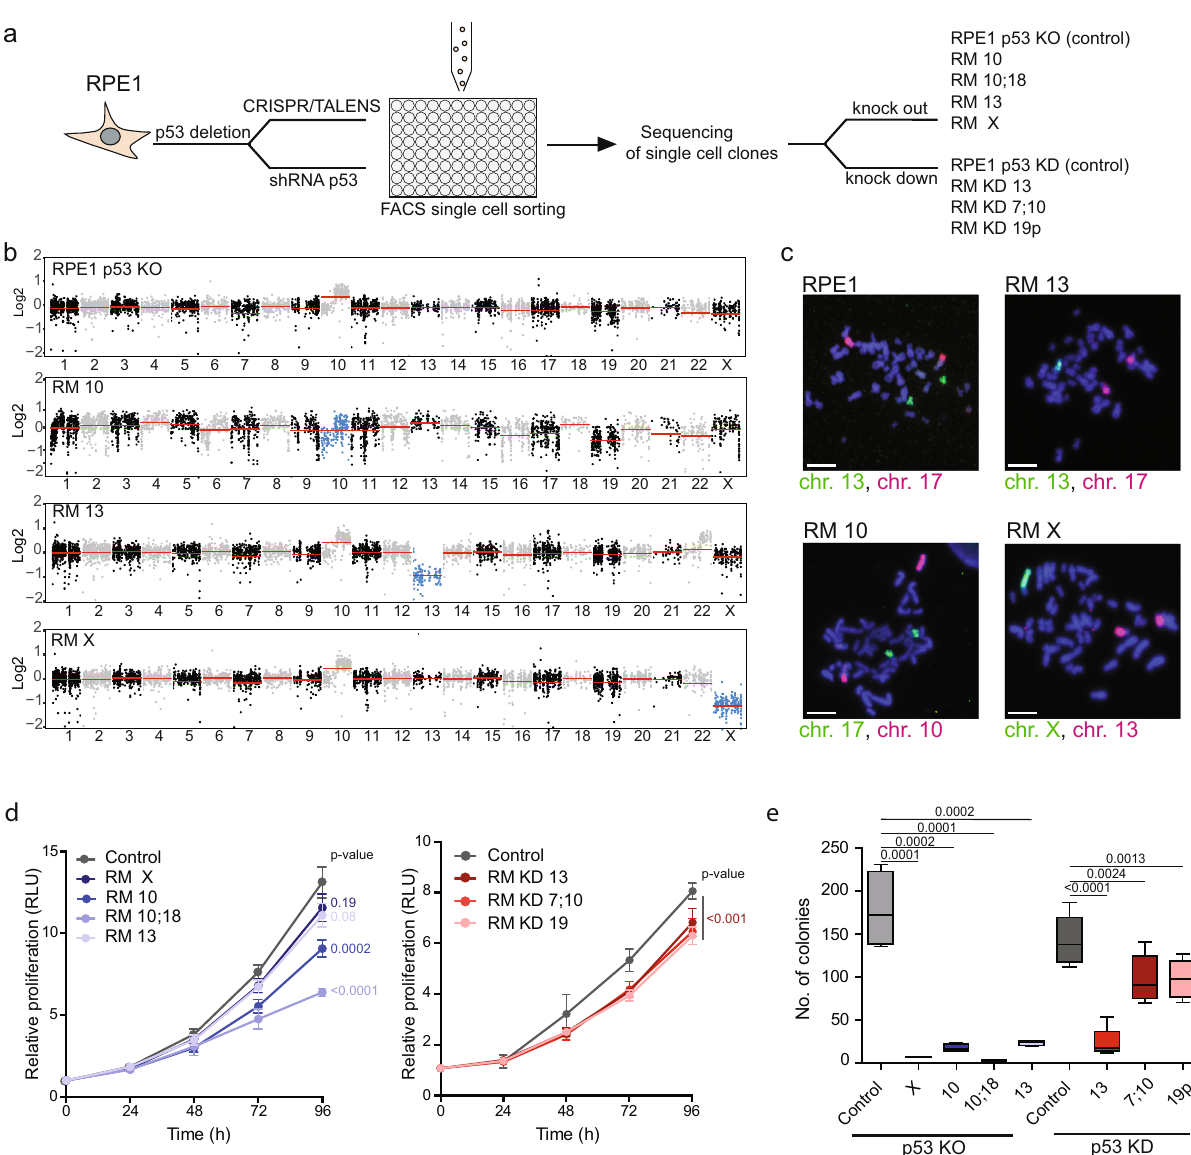
Fig. 1 Chromosome loss in p53 de fi cient cells reduces proliferation and anchorage independent growth on soft agar. a Schematic depiction of the construction of monosomic cells. p53 was mutated or depleted in RPE1-hTERT cell line via CRISPR/Cas9, TALENS, or shRNA expression. Clones arising from single cells were subjected to whole-genome sequencing and monosomic clones were selected to be used in further experiments. b Read depth plots of all chromosomes in control and RM samples. Chromosome losses are marked in blue. Red lines indicate the copy number of each chromosome. Note that the parental RPE1 contains an extra copy of 10q that is preserved in all monosomic derivatives. c Chromosomal paints of monosomic cell lines. The painted chromosomes are indicated with respective colors. Representative images of one experiment are shown. Scale bar — 10 µ m. d Proliferation curves of monosomic cell lines in comparison to respective diploid controls. All the values are normalized to day 0. Each point represents the mean ± SEM. Number of biological replicates: RPE1 P53 KO control = 7, RM X = 7, RM 10 = 7, RM 10;18 = 7, RM 13 = 7; RPE1 P53 KD control = 5, RM KD 13 = 5, RM KD 7;10 = 5, RM KD 19p = 5). RLU-relative luminescence unit. Statistical signi fi cance is calculated using linear regression analysis; p -values are shown in the plots. e Quanti fi cation of number of colonies growing on soft agar. The median is shown as a black bar and Whiskers are chosen to show the 1.5 of the interquartile range. Number of biological replicates: RPE1 P53 KO control = 4, RM X = 4, RM 10 = 4, RM 10;18 = 4, RM 13 = 4; RPE1 P53 KD control = 8, RM KD 13 = 8, RM KD 7;10 = 8, RM KD 19p = 8. Statistical analysis was performed using one-tailed unpaired T -test; p -values are shown on the plot. Source data are provided in a Source Data fi Gene expression changes caused by monosomy are partly autophagy proteins was not uniformly deregulated (Supplemen- buffered at both mRNA and protein levels . To obtain a global tary Fig. 2a – e). Taken together, a loss of single chromosome leads to proliferation defects and to heterogeneous changes in view of the expression changes induced by chromosome loss, we maintenance of genomic instability, but does not trigger performed transcriptome and proteome analyses of monosomic replication defects and proteotoxic stress, implying that the cell lines RM 10;18, RM 13, RM 19p, and RM X. The obtained affected molecular processes do not parallel the previously transcripts were normalized to the parental control cell line and identi fi ed effects of chromosome gains. visualized as the log 2 fold changes (FC) according to the